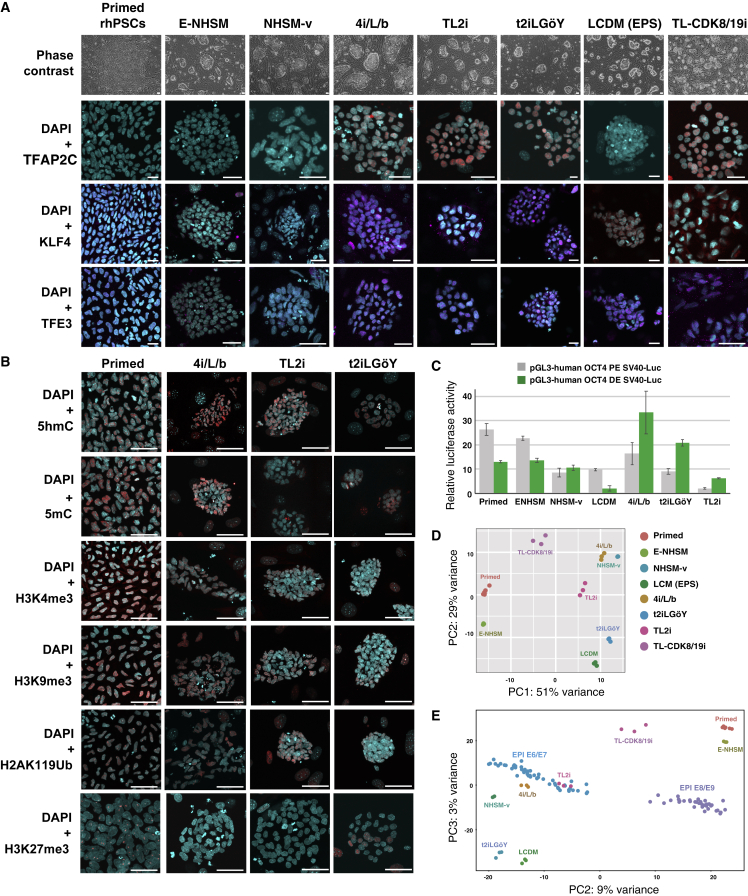
Characterization of Rhesus PSCs after Reprogramming to Naive Pluripotency(A) Phase contrast and immunostaining of naive pluripotency markers, TFAP2C, KLF4, and TFE3 in LyonES-tGFP-(S3) cells, before (primed rhesus PSCs) and after reprogramming to the naive state (E-NHSM, NHSM-v, 4i/L/b, TL2i, t2iLGöY, LCDM (EPS), and TL-CDK8/19i) (confocal imaging). Scale bars, 50 μm.(B) Immunostaining of 5′-methylcytosine (5mC), 5′-hydroxymethylcytosine (5hmC), H3K4me3, H3K9me3, H2AK119Ub, and H3K27me3 in LyonES-tGFP-(S3) cells, before (primed) and after reprogramming to the naive state (4i/L/b, TL2i, and t2iLGöY) (confocal imaging). Scale bars, 50 μm.(C) Activity of the proximal and distal enhancers (PE and DE, respectively) of OCT4 measured in a luciferase assay after transient transfection in primed PSCs, E-NHSM, NHSM-v, 4i/L/b, TL2i, t2iLGöY, and LCDM cells.(D) Principal-component analysis (PCA) for primed PSCs, E-NHSM, NHSM-v, 4i/L/b, TL2i, t2iLGöY, LCDM, and TL-CDK8/19i populations based on RNA sequencing (RNA-seq) data.(E) PCA for primed PSCs, E-NHSM, NHSM-v, 4i/L/b, TL2i, t2iLGöY, LCDM, and TL-CDK8/19i populations based on bulk RNA-seq and single-cell RNA-seq data of cynomolgus epiblast from E6 to E9 embryos (Nakamura et al., 2016).